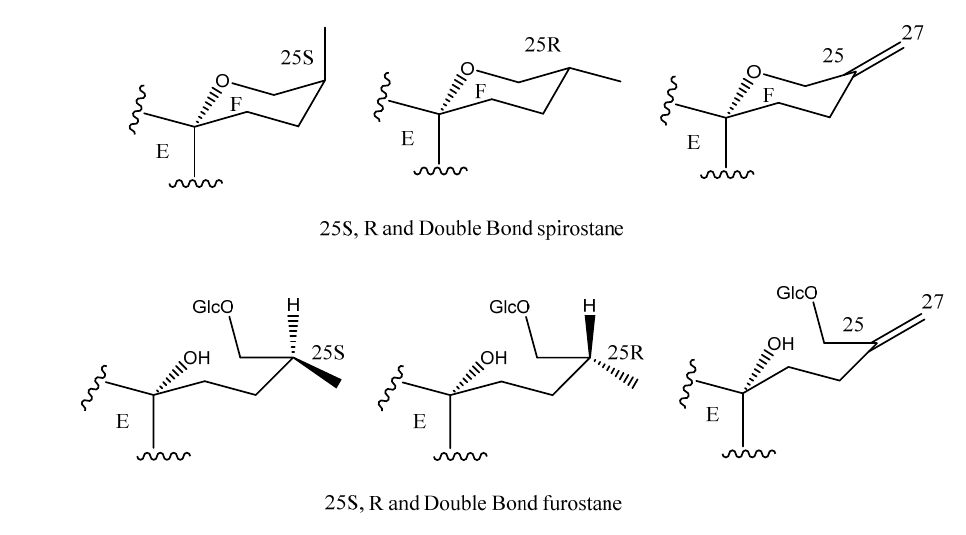
Figure 5. Structure of steroidal aglycones on the C-25.